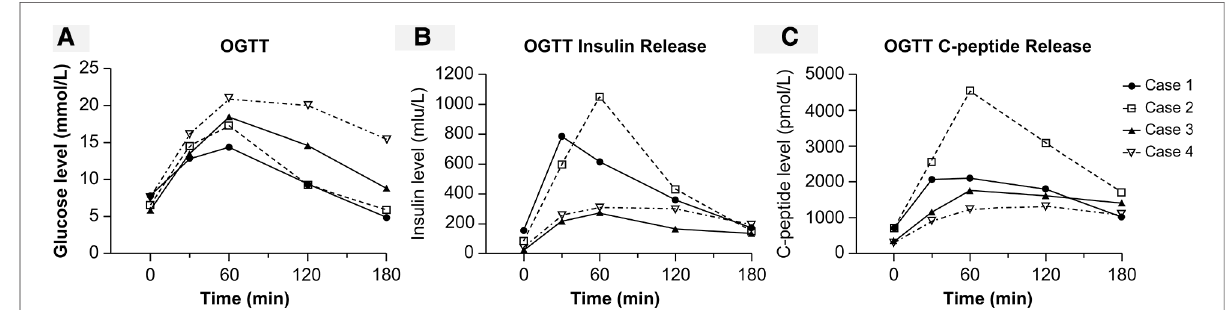
FIGURE 3 Results of pancreatic endocrine function, including the 75 g OGTT during the follow-up studies. ( A ) OGTT curve; ( B ) OGTT insulin-release curve; and ( C ) OGTT C-peptide release curve. OGTT=oral glucose tolerance